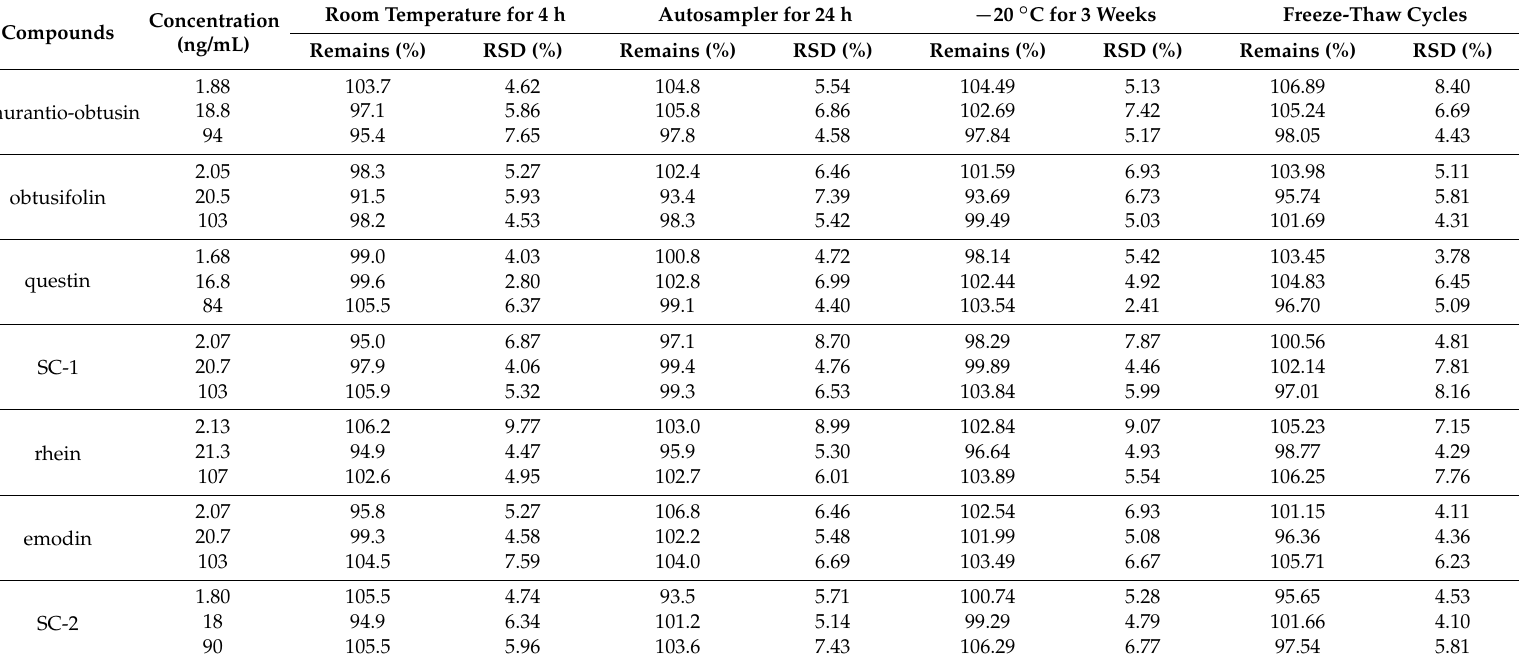
Table 4. Stability of the seven analytes in rat plasma ( n =